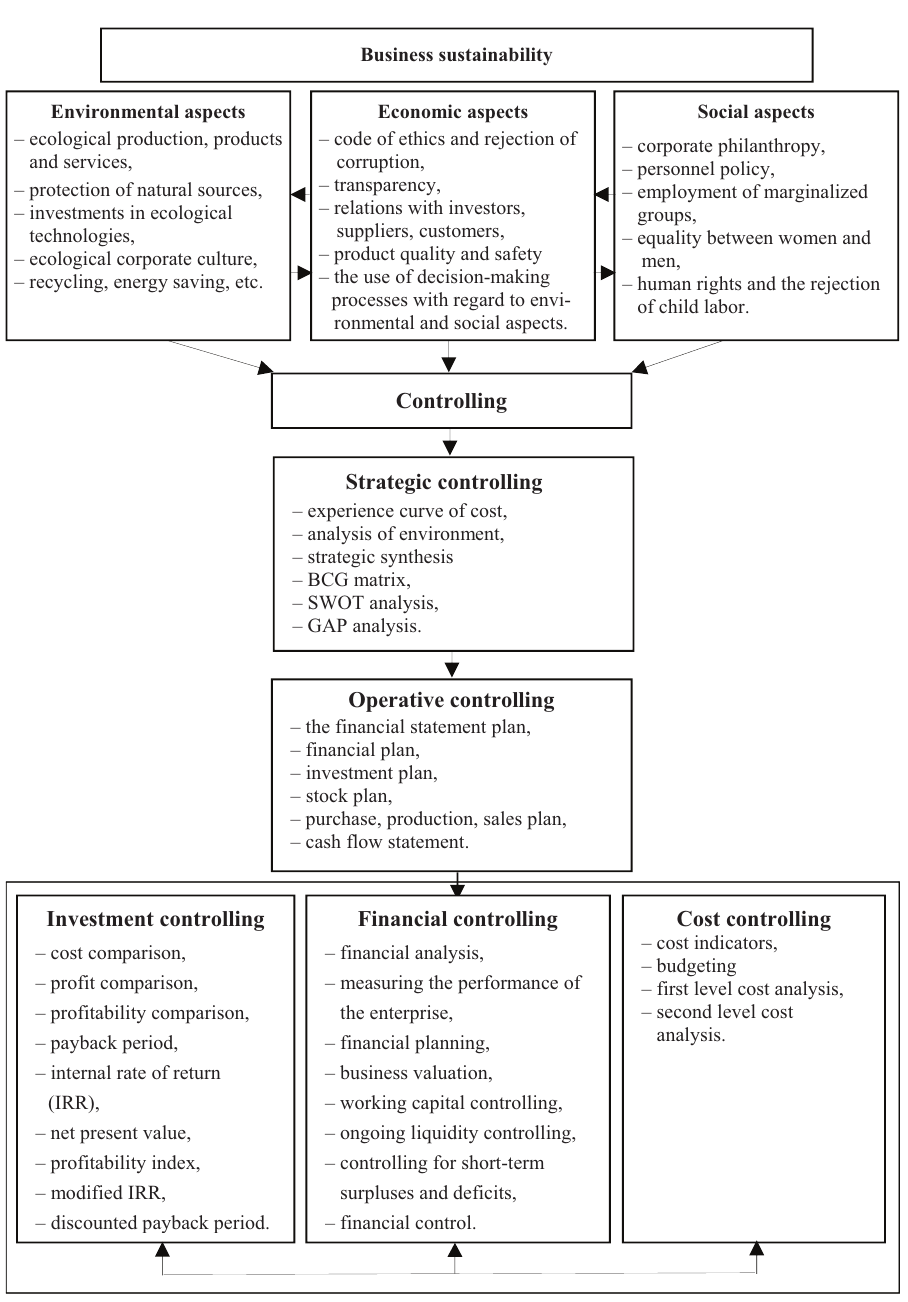
Figure 4. Sustainable controlling business